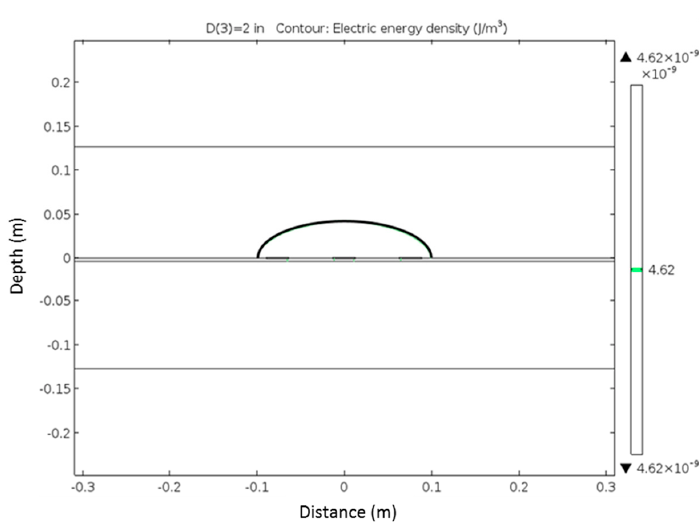
Figure 11. Contour of the electric energy density that demonstrates the effective sampling volume (assuming 90% contribution to the total energy density).